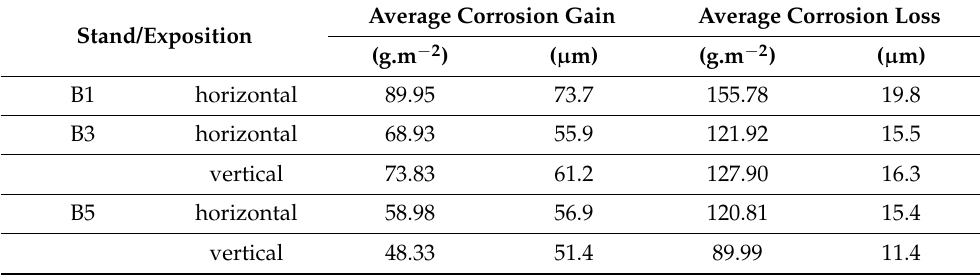
Table 24. Average corrosion increment and loss after 1 year of